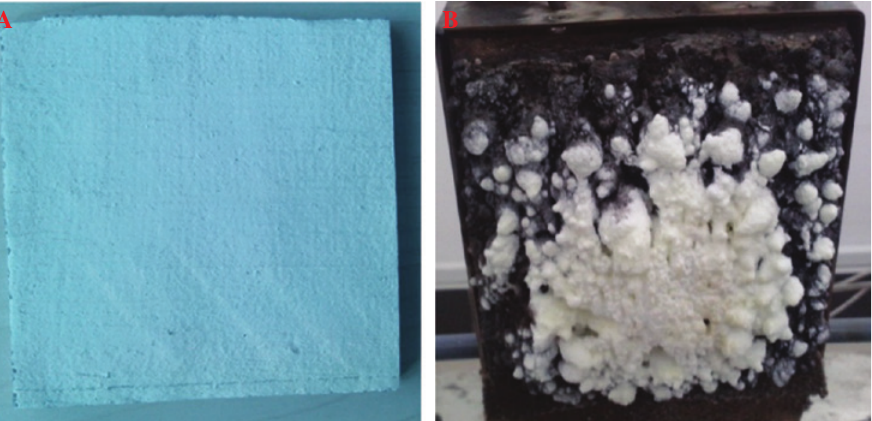
Figure 2: Photographs of intumescent coating before (A) and after (B) fire hazard.